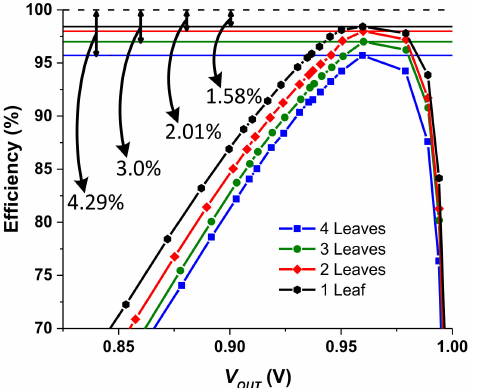
Figure 4. Effect of switch width modulation using leaf enable mechanism on efficiency of 2:1 converter at I LOAD = 500 nA.